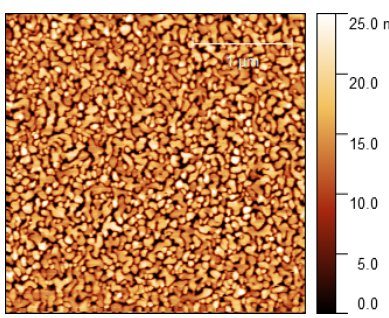
Figure A1. Topography of the 15 nm thickness Au film on mica imaged in AFM constant force mode; average surface roughness R a = 4.31 nm, scan size 3 × 3 µ m 2